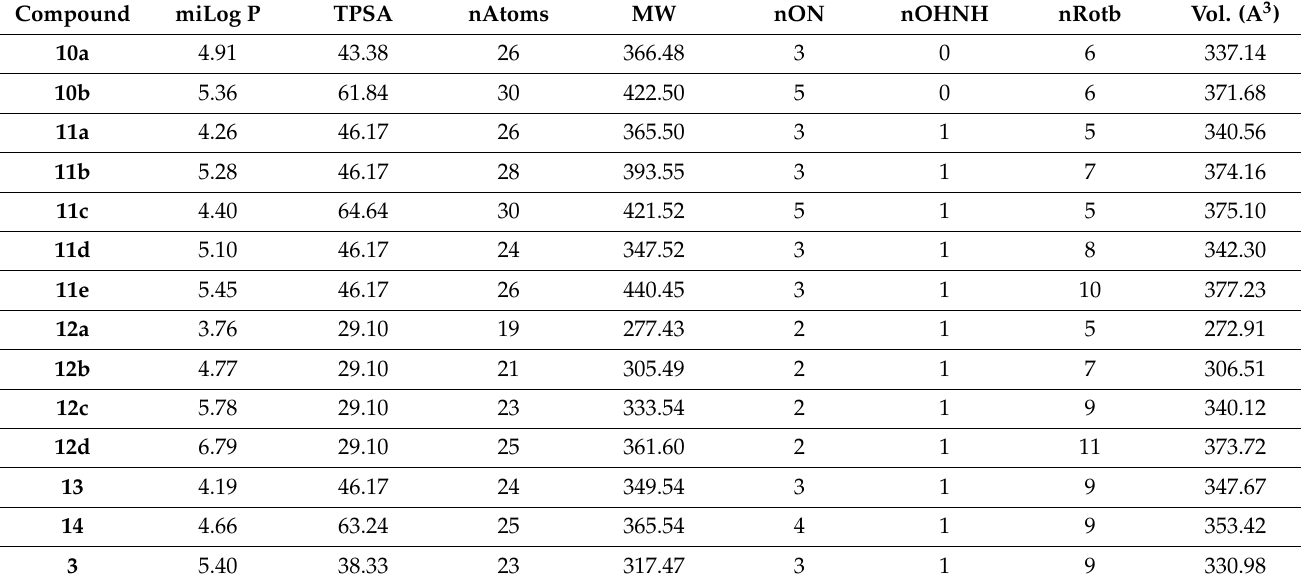
Table 1. Calculations of molecular properties of synthesised compounds using Molinspiration. Compound